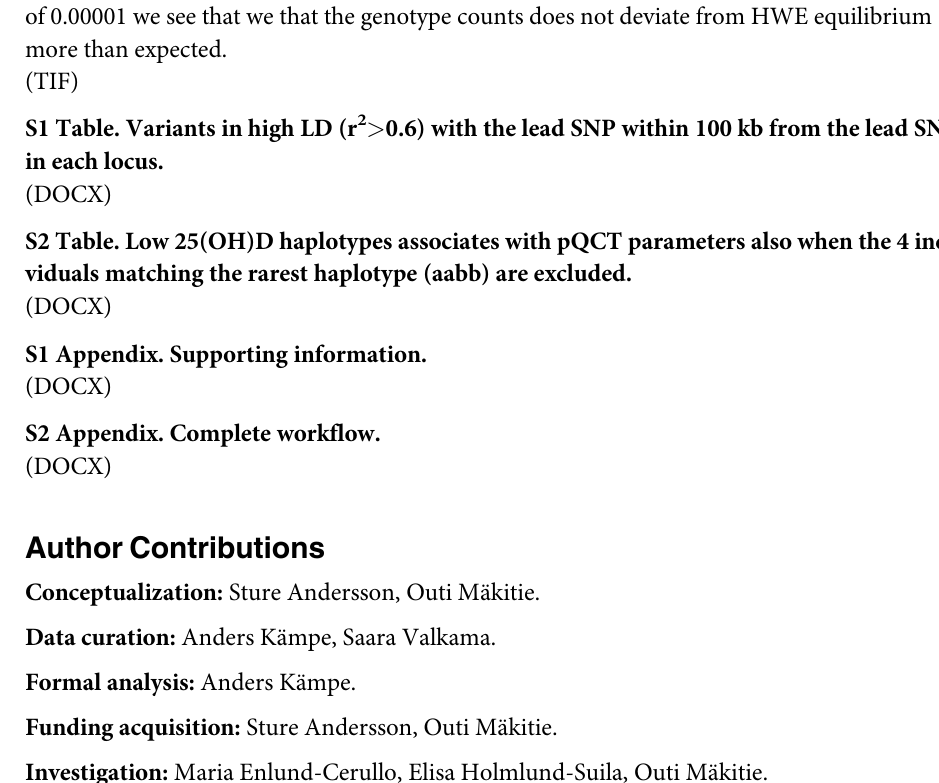
S2 Fig. Study data vs GTEx data for the chromosome 11 locus. Comparison of the associa- tion statistics for 25(OH)D in 24-month old children within the 200kb target window on chro- mosome 11 compared to the GTEx eQTL dataset for the genes PDE3B (tissue: Pancreas) and RRAS2 (tissue: Tibial Nerve). All SNPs that both show a significant association statistic and are present in both datasets are colored either blue (-) or red (+), depending on the direction of the SNP’s beta coefficient. The results show, just as with CYP2R1 (tissue: Thyroid) a complete concordance in the direction of SNPs’ association with 25(OH)D levels in our study and gene expression in the GTEx dataset. Our study data is presented above the line y = 0 and the GTEx data below it. (red line: genome-wide significance; blue line: genome-wide suggestive signifi- cance; orange line: FDR 0.05) S3 Fig. Ancestry inference. A 4-dimensional reference space was created using data from the European subset of the 1000 genomes phase 3 population. Out of the 503 European individu- als, 99 have Finnish descent. Each study individual has subsequently been projected from a 20-dimensional genetic map onto the 4-dimensional reference map. To the left the study indi- viduals have been overlaid (black dots), to the right the original reference maps are shown. The black rectangle describes the space within 4SD of the 99 Finnish individuals. S4 Fig. QQ-plot of HWE p-values. When using a Hardy Weinberg equilibrium p-value cutoff of 0.00001 we see that we that the genotype counts does not deviate from HWE equilibrium more than expected. S1 Table. Variants in high LD (r 2 > 0.6) with the lead SNP within 100 kb from the lead SNP in each locus. S2 Table. Low 25(OH)D haplotypes associates with pQCT parameters also when the 4 indi- viduals matching the rarest haplotype (aabb) are